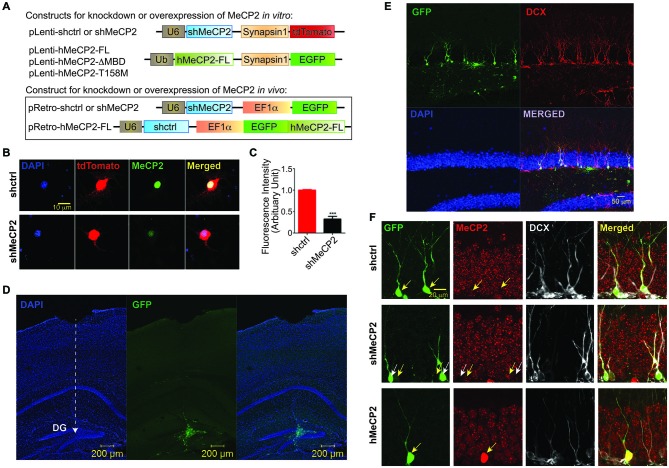
Efficiency of MeCP2 knockdown in cultured primary hippocampal neurons. (A) Schematic diagram showing lentiviral constructs for knocking down MeCP2 or expressing hMeCP2 (FL, ΔMBD or T158M) in vitro as well as retroviral constructs for checking the efficiency of MeCP2 knockdown or overexpression in progenitor cells in vivo. (B) Representative images from immunocytochemistry of MeCP2 in cultured hippocampal neurons at DIV 12 showing efficient knockdown of MeCP2 in
vitro. (C) Quantification of fluorescence intensity of cells expressing shctrl or shMeCP2 that were immunostained with antibody against MeCP2 (***p < 0.001, Student’s t-test, n = 3 batches). (D) Low magnification (10x) images showing the virus injection site and needle track (dashed white line with arrow pointed at the end point of injection) in dentate gyrus (DG) of the mouse brain. (E) High magnification (20x) images showing the virus infected neurons co-localized with DCX (immature neuron marker). (F) Representative images showing efficiency of MeCP2 knockdown or overexpression in progenitor cells in the DG in vivo (Immature neurons identified with anti-doublecortin (DCX)). Virus-infected neurons (green) and their MeCP2 expression (red) were indicated on images with corresponding yellow arrows. shMeCP2-expressing cells in middle panel (pointed by white arrows) show no or very low expression of MeCP2 demonstrating efficient knockdown.